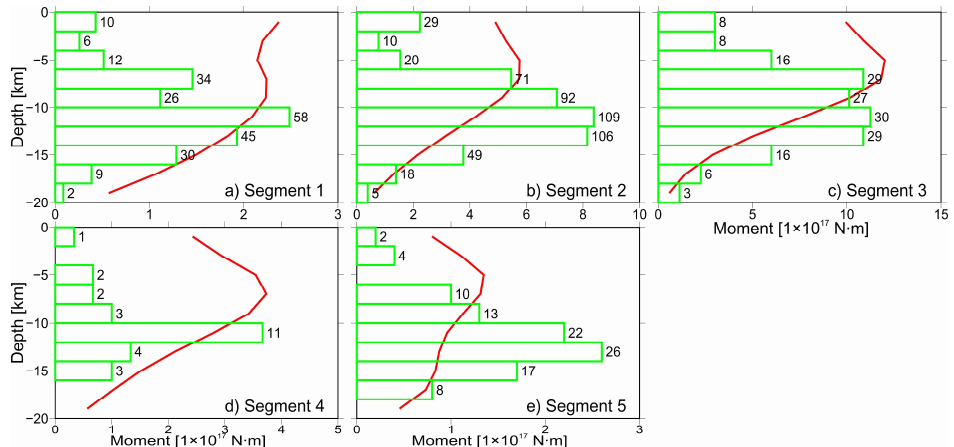
Figure 8. Depth distribution of the accumulative moment (red curve) and number of aftershock for five fault